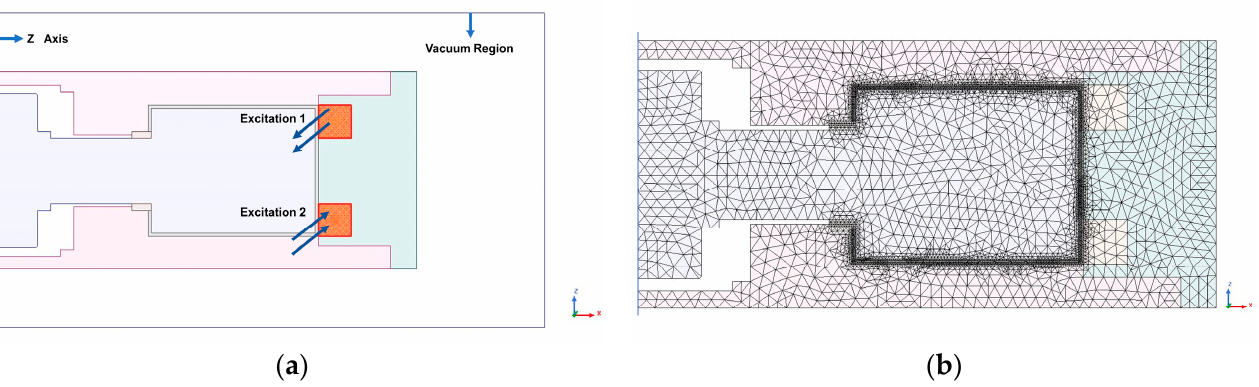
Figure 9. Magnetic field analysis simulation setup of axial multi-coil configuration: ( a ) excitation and boundary settings; ( b ) finite element meshing.